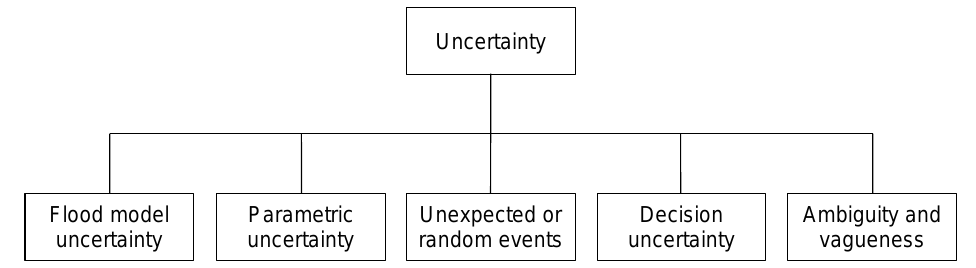
Figure 5. Classification of uncertainty in flood risk.